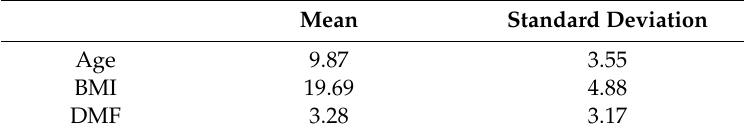
Table 5. Mean value and standard deviation of the age, body mass index (BMI) and DMFT index of the sample.